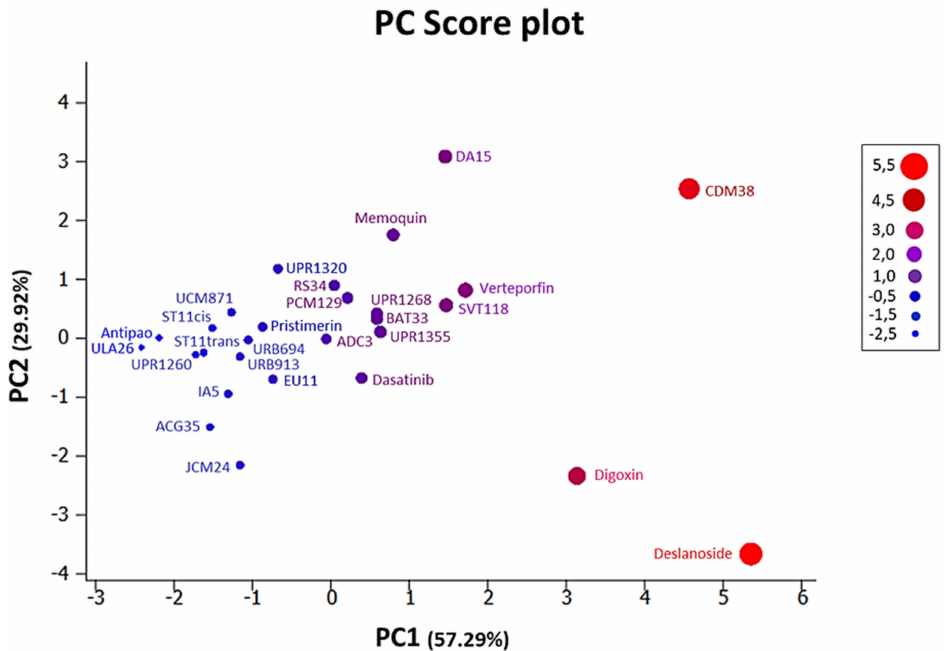
Figure 3. PC score-plot. This graph shows the PCA scores of the entire chemical collection, repre- sented by a traffic-light system. Each dot refers to a single compound. Verteporfin and dasatinib were included in the original dataset as reference compounds. Based on the PC1 mapping distance (from − 3 to +6), the library covers different regions of the chemical space. Deslanoside, CDM38 , and digoxin share very similar physicochemical properties, while they are strongly dissimilar with respect to compounds located at opposite sides of PC1 (i.e., Antipao and ULA26 ). Based on the mapping of PCA scores, the original database consists of more blue-to-purple chemical entries (medium-high level of molecular complexity), and five main clusters were identified: cluster 1 (blue): antipao, ULA26 ; cluster 2 (persian blue): UCM871 , ST11cis , ST11trans , UPR1260 , IA5 , ACG35 , JCM24 ; cluster 3 (navy blue): EU11 , pristimerin, UPR1320 , URB694 , URB913 ; cluster 4 (violet-purple): memoquin, ADC3 , RS34 , PCM129 , UPR1355 , BAT33 , UPR1268 , dasatinib, DA15 , SVT118 , verteporfin; cluster 5 (magenta-cherry-red): digoxin, CDM38 ,